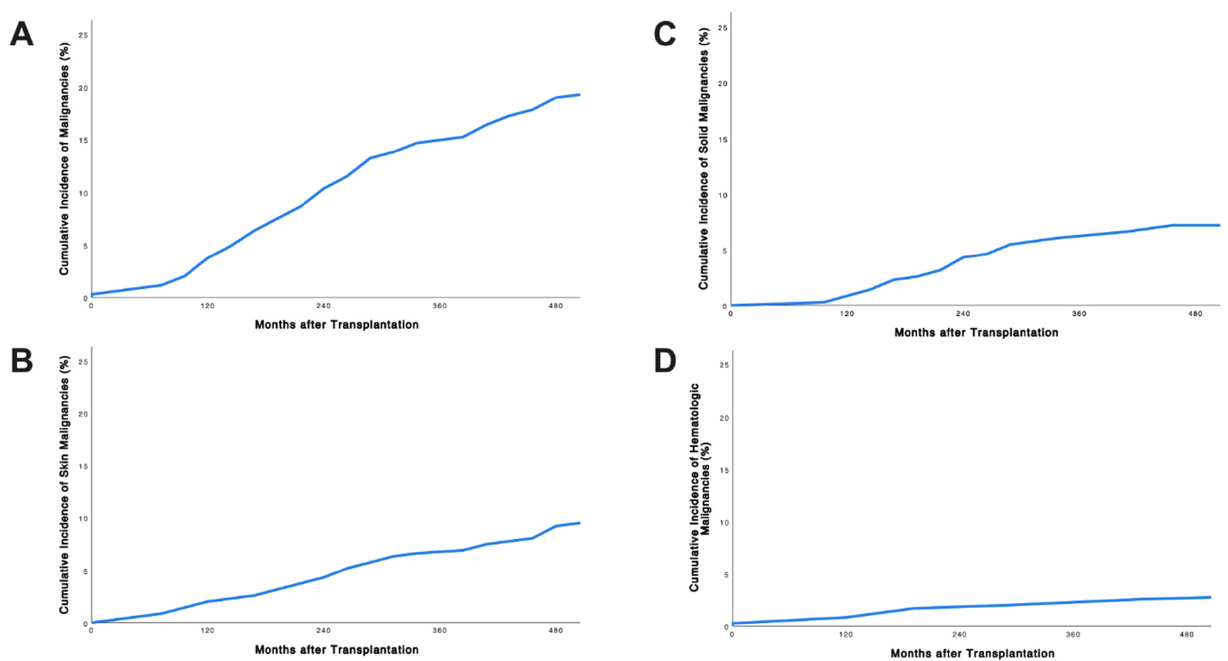
Figure 1. Overall cumulative incidence ( A ) as well as cumulative incidence of skin ( B ), solid ( C ), and hematologic ( D ) post-transplant malignancies (PTMs) after pancreas transplantation is shown. The median time to malignancy was 130 months and similar between all types of PTMs (log-rank p = 0.125).